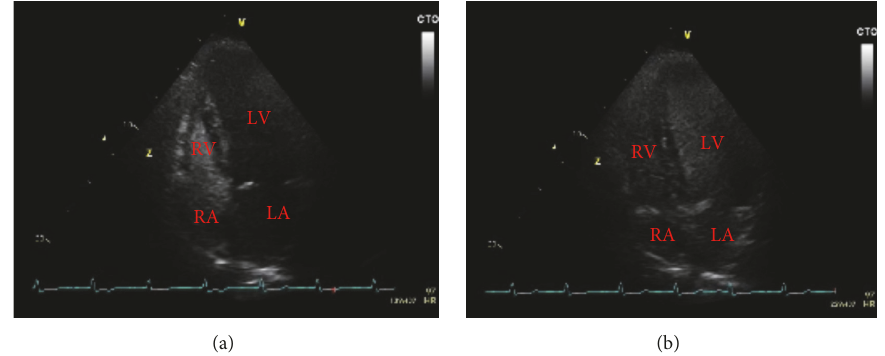
Figure 5: (a) Contrast/“bubble” TTE at time of injection. (b) Contrast/“bubble” TTE showing extensive opacification of the left heart in 4-5 cardiac